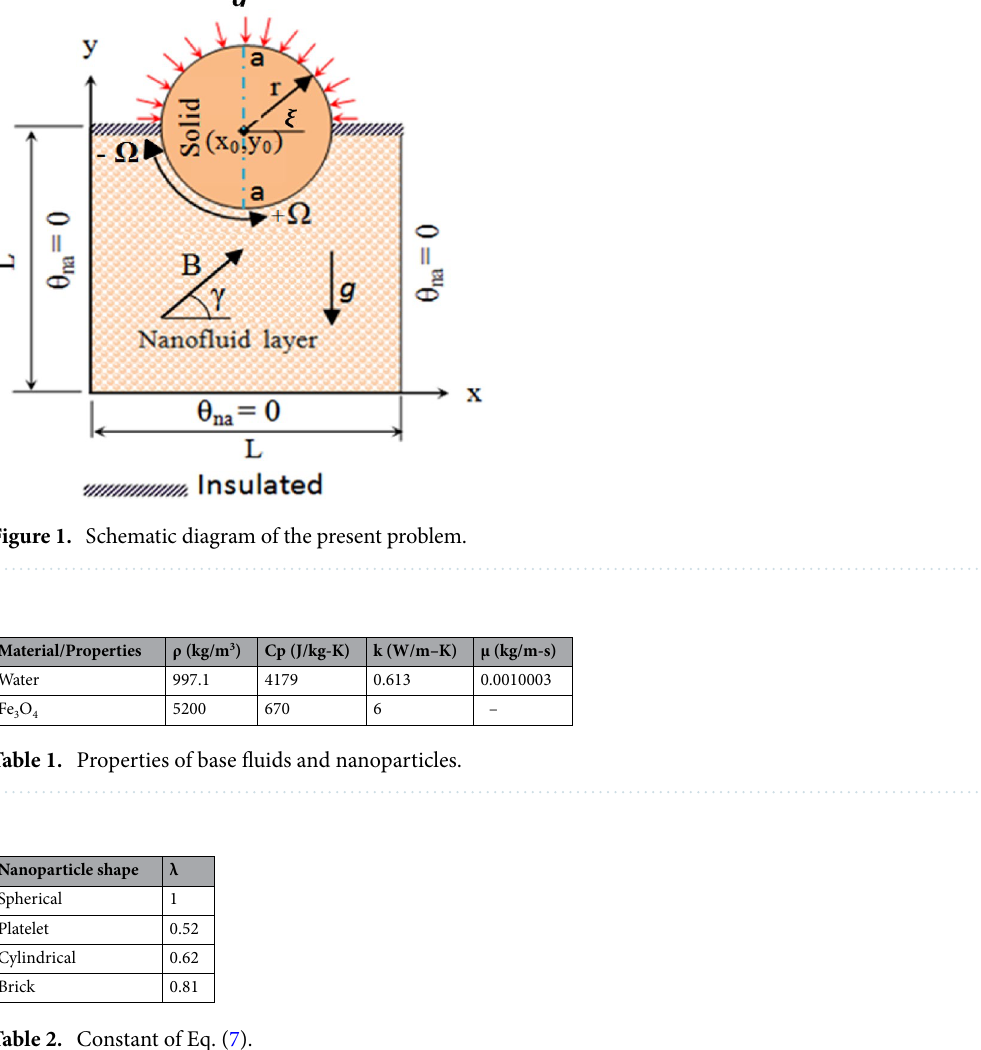
Table 2. Constant of Eq.